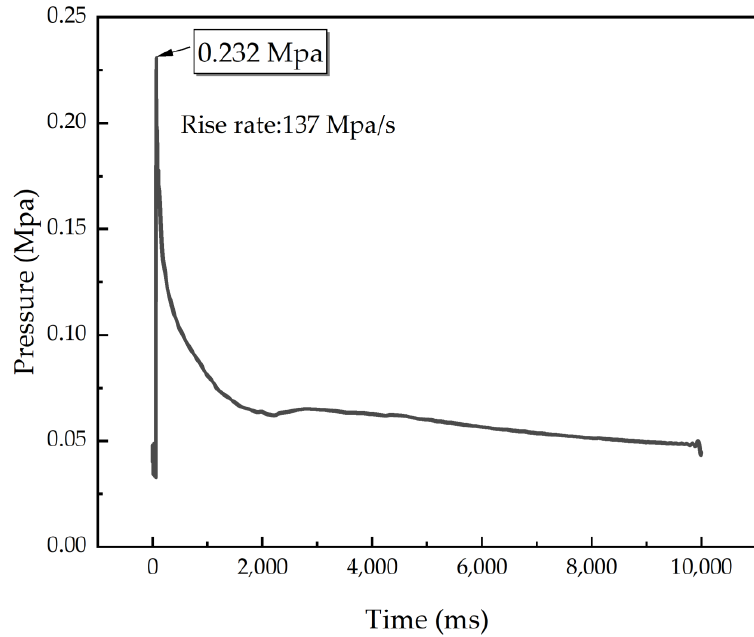
Figure 6. P – t curve of C 8 H 18 -Al nanoparticles. Figure 6. P–t curve of C